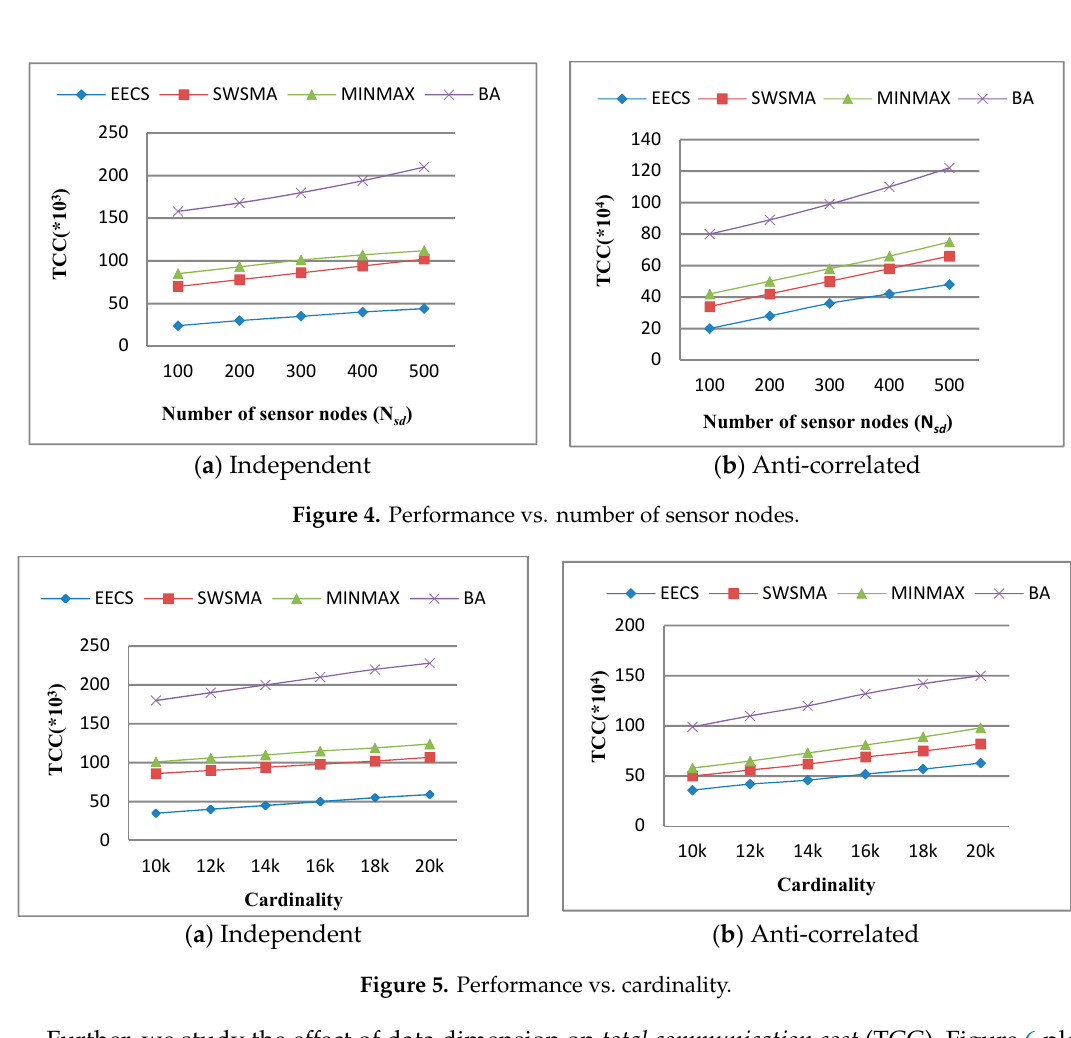
Figure 5. Performance vs. cardinality.